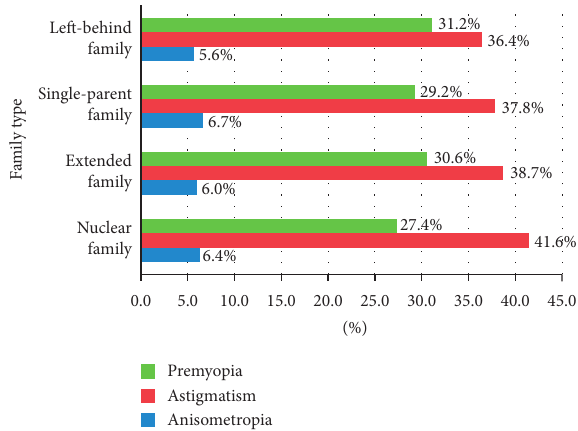
Figure 2: Prevalence of premyopia, astigmatism, and anisometropia in different family